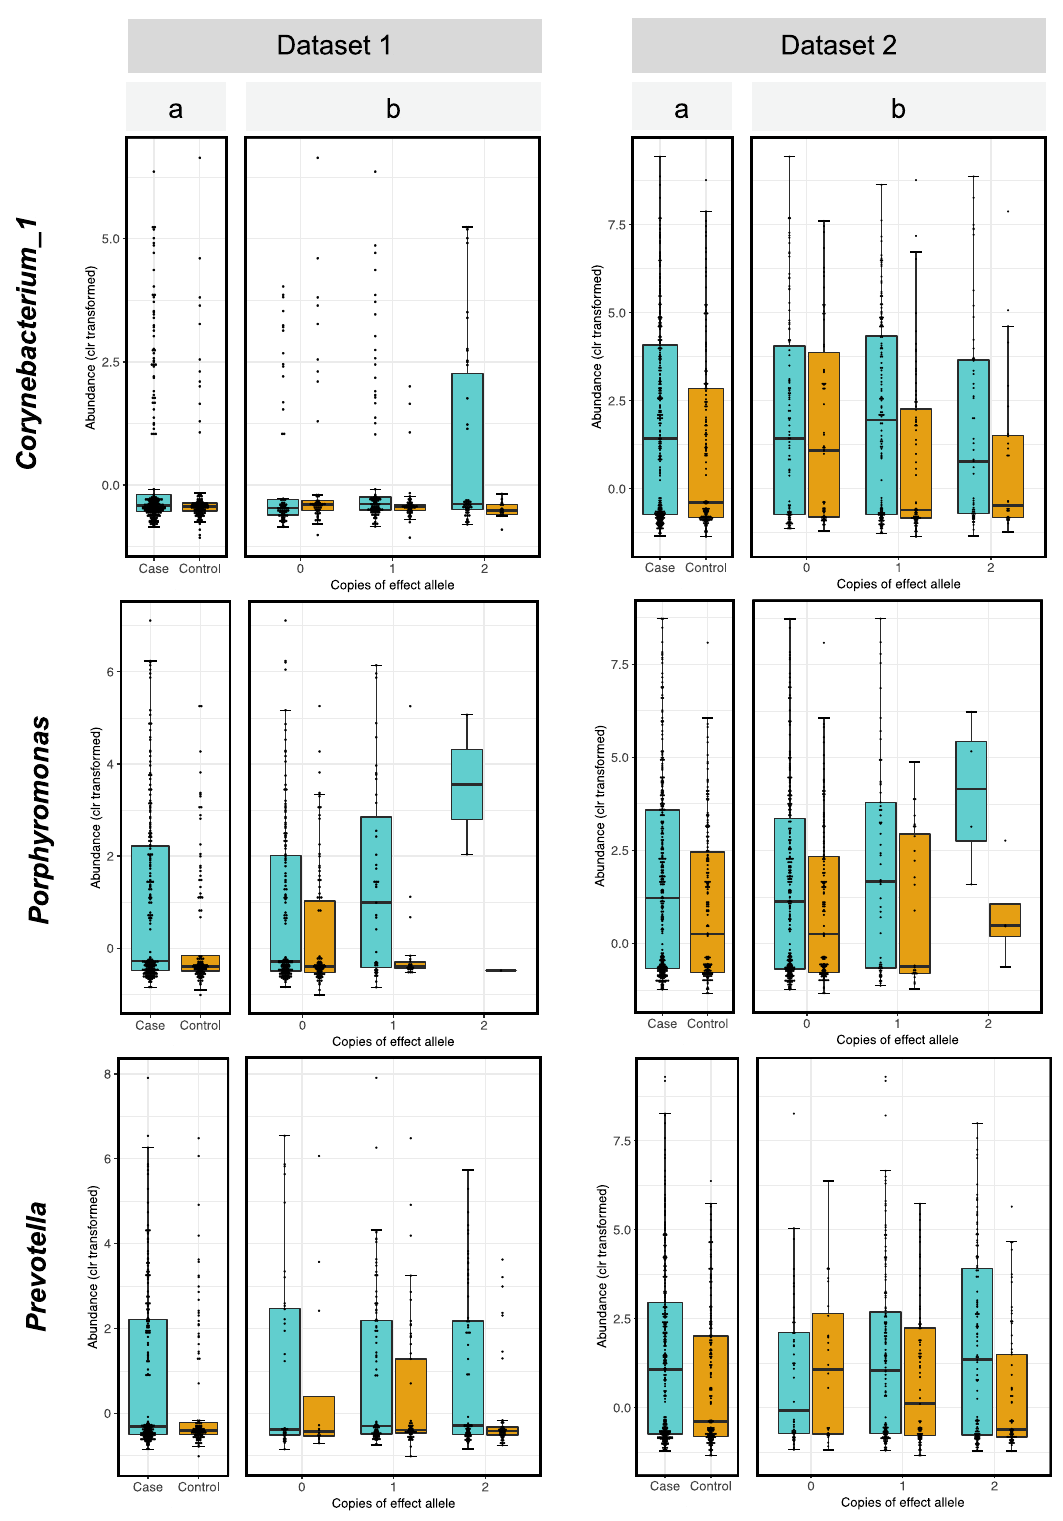
Fig. 2 Differential abundance of opportunistic pathogens. Clr-transformed abundances of each taxon are plotted for PD cases (blue) and controls (orange) for all subjects irrespective of genotype (panel a) and strati fi ed for the three genotypes of the interacting SNP (panel b). The bottom, middle, and top boundaries of each box represent the fi rst, second (median), and third quartiles of the clr-transformed abundances. Lines extending from the top and bottom of boxes show 1.5 times the interquartile range. Points extending above or below the horizontal caps of the top and bottom lines of each box are outliers. The two datasets show the same pattern of interaction where the difference between PD and controls in the abundances of each taxon becomes larger with increasing number of the effect allele. Dataset 2 has higher resolution than dataset 1 (particularly for Corynebacterium_1 which is rare) because it had 10x greater sequencing depth.